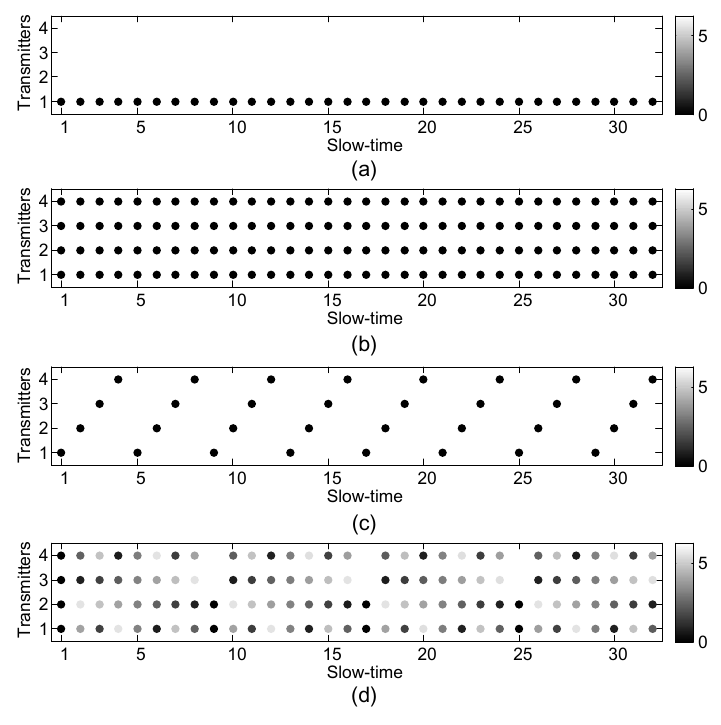
Figure 2. The radian phases of the space-time modulation matrix for ( a ) SIMO; ( b ) CDMA/FDMA; ( c ) TDMA; ( d )